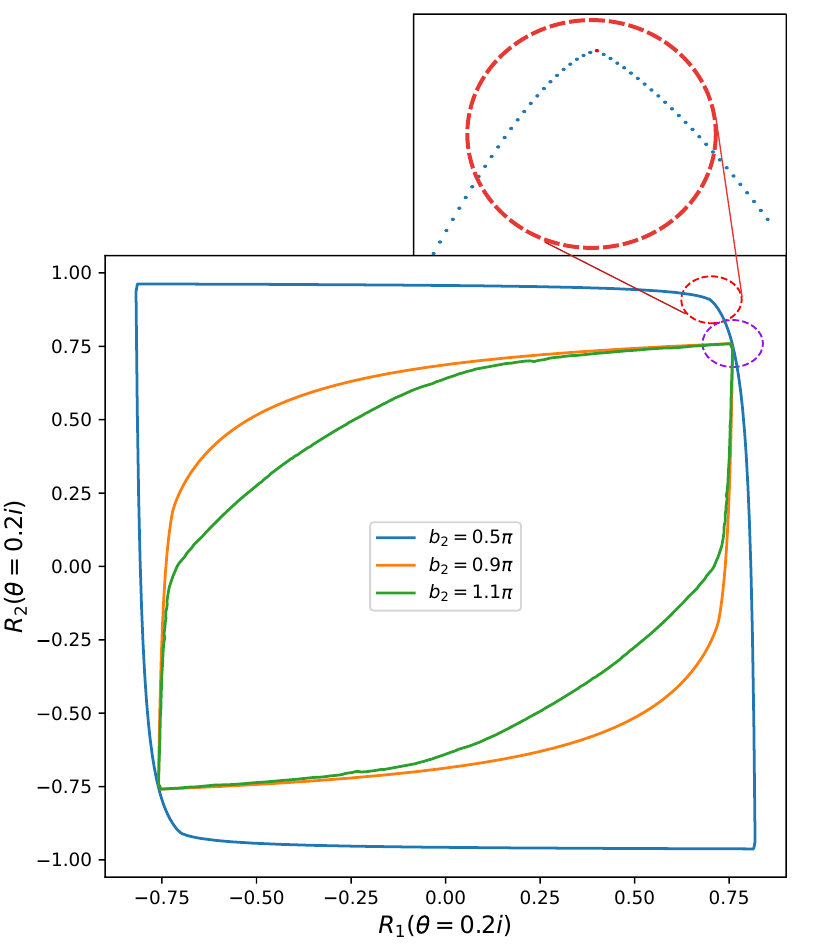
Figure 4 . Plot of the ( R 1 ( θ 1 ) , R 2 ( θ 1 )) , θ 1 = 0 . 2 i , allowed region for the NLSM with N = 6 , k = 1 and various analytic regions b = 0 , b = π , 0 . 9 π , and b 1 = − 0 . 1 π , b 2 = 1 . 1 π . The vertex at the 1 2 2 center of the red circle (see rotated and rescaled inset) is the R-matrix in eq. (1.26) with N = 6 , k = 1 . A new vertex appears in the smaller regions, namely the one at the center of the purple circle that corresponds to a solution with R = R , or N = 6 , k = 0 1 2